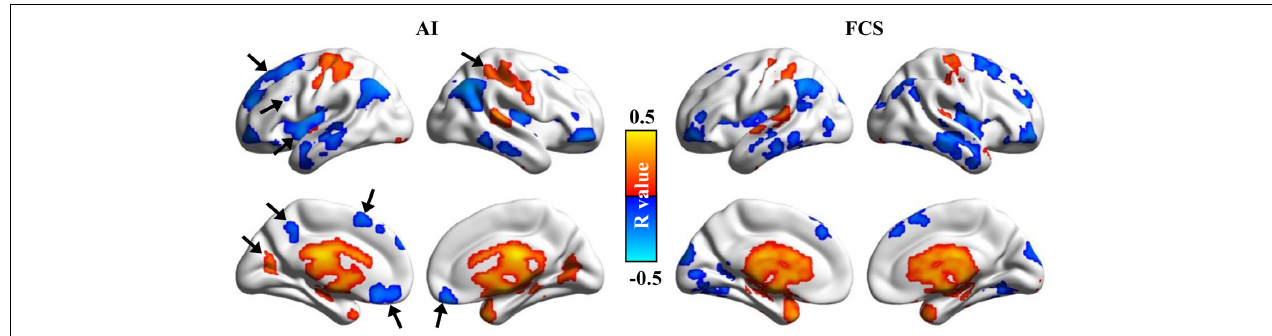
FIGURE 5 | Aging effects were revealed using the Asso and FCS methods. The voxel-wise correlation analyses between ages and Asso, FCS were performed. Significantly positive and negative correlations between ages and Asso, FCS were found. We found that Asso could be more effective in identifying aging-related brain